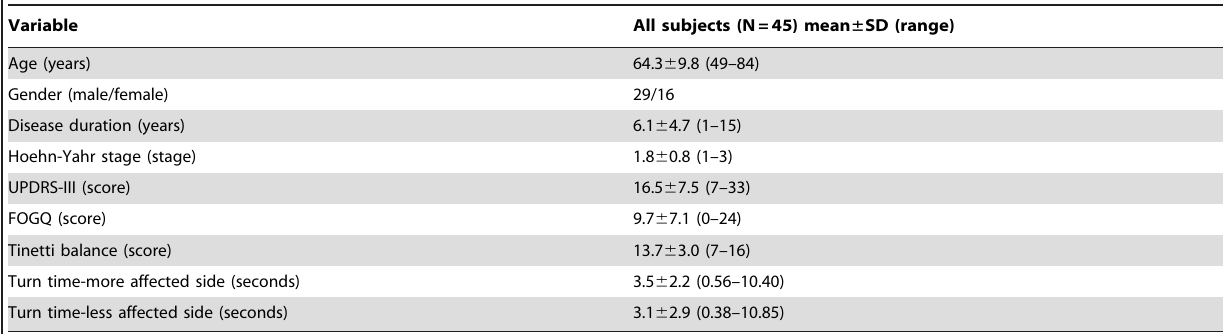
Table 1. Demographic and disease